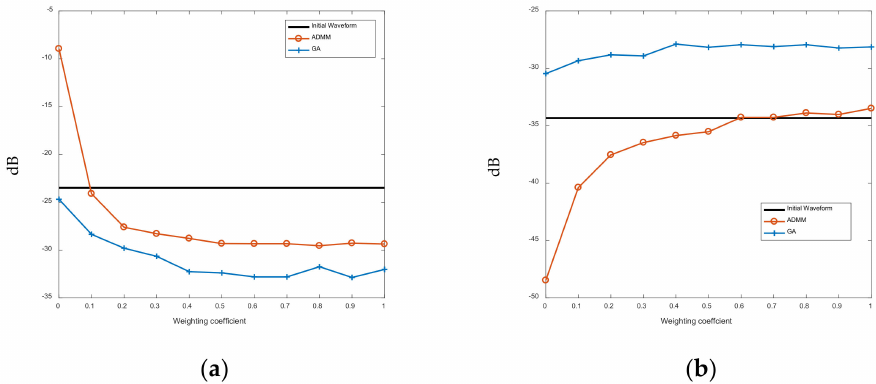
Figure 9. The AC-ASL and the CC-AL of the FSK-PSK signal before and after optimization. ( a ) AC-ASL result. ( b ) CC-AL result.